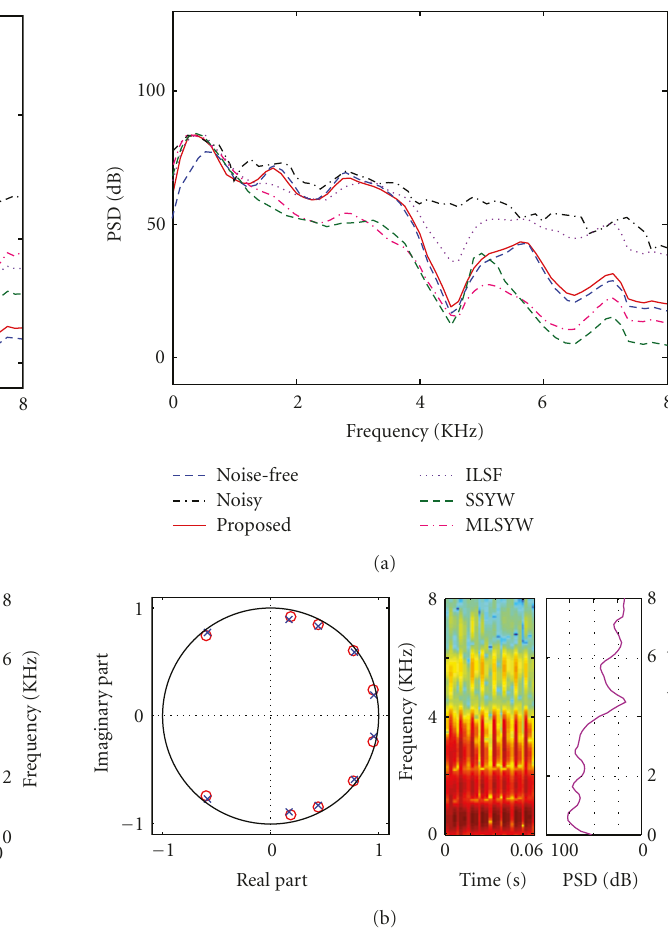
Figure 6: Estimation results for a natural speech phoneme /a/ in the presence of a multitalker babble noise at SNR = − 5dB. (a) PSD obtained by using di ff erent methods, (b) Average estimated poles ( × ) obtained from noise-corrupted speech by using the proposed method along with the noise-free estimates ( (cid:9) ) obtained by the MLSYW method, wide-band spectrogram of the noise-free speech, and noise-free